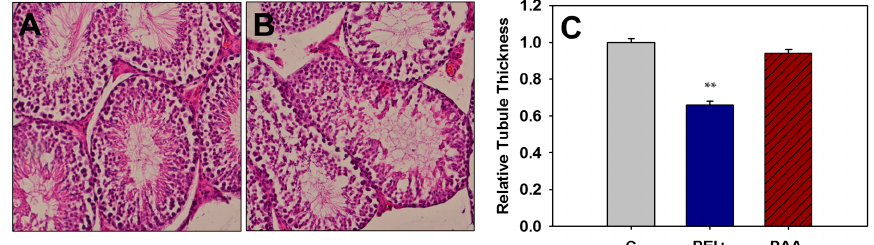
Figure 5. Hematoxylin and eosin stained testis sections from adult control mice ( A ) or those exposed to 100 mg/kg of iron oxide NPs in utero ( B ) (magnification of A , B : 200×). Relative germinal epithelial thicknesses of the seminiferous tubule ( C ) were measured for all treatment groups exposed to 100 mg/kg iron oxide NPs in utero and the control, C, with GD 8, 9, and 10 pooled for all analyses. ** Significant differences between treatment group and the control ( p < 0.01).